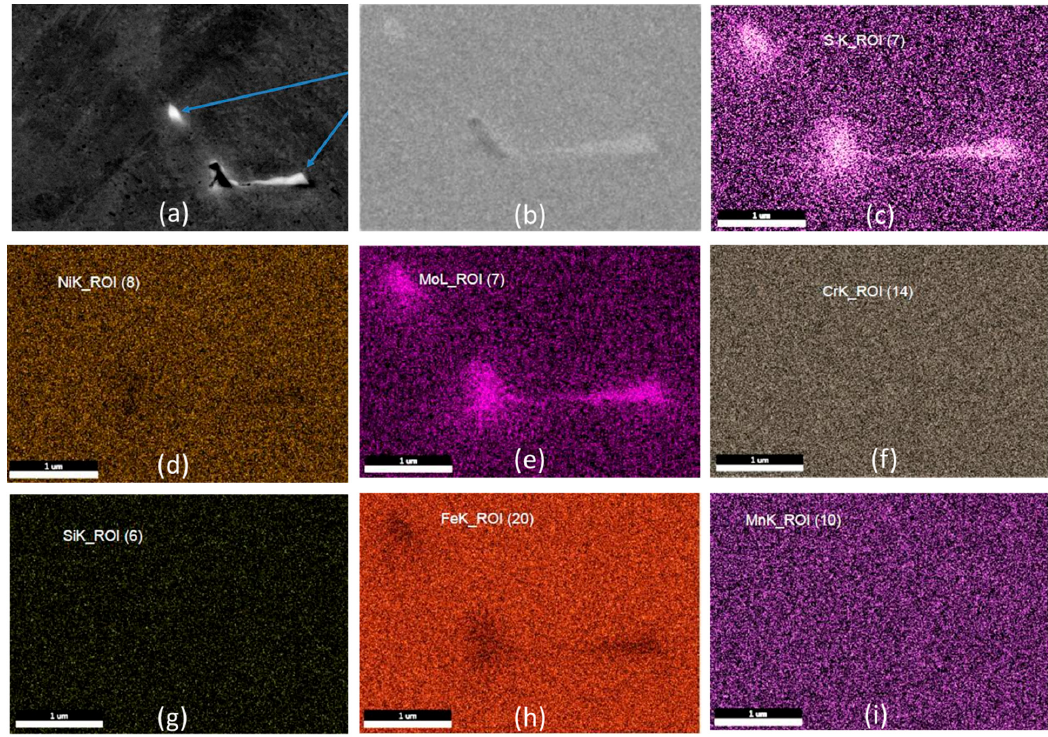
Figure 6. Characterization of inclusions using EDS. ( a ) The inclusions, ( b ) Gray scale of inclusions. Overlapping spectra of S and Mo visible in ( c ) Sulfur and/or ( d ) Nickel, ( e ) Molybdenum in the microstructure of the PHILOS plate. While the rest ( f ) Chromium, ( g ) Silicon, ( h ) Iron and ( i ) Manganese are not visible.